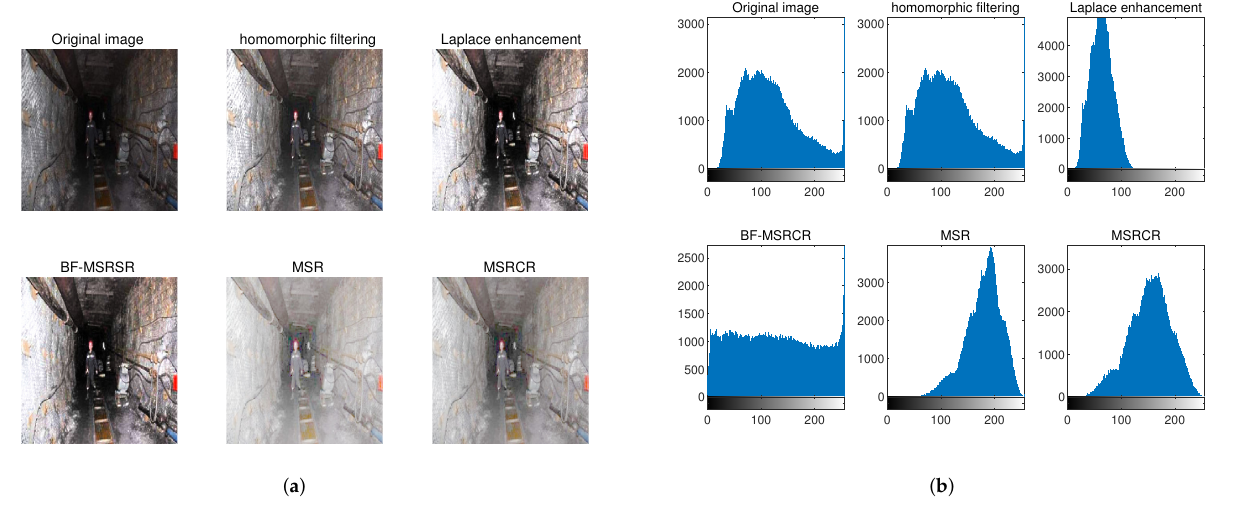
Figure 9. Image 2 algorithm and greyscale histogram comparison. ( a ) Image 2 algorithm comparison; ( b ) Image 2 algorithm and greyscale histogram